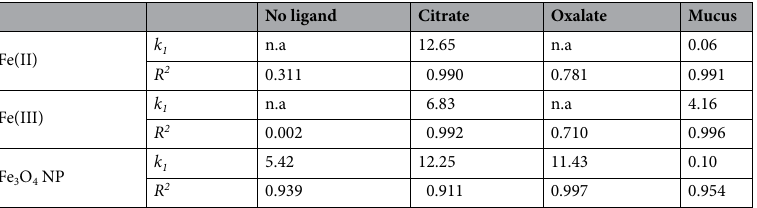
Table 1. Apparent kinetic rate constants of the first-order, (10 2 k 1 ; min −1 ) and corresponding correlation coefficients ( R 2 ) calculated from the reaction kinetics of bromophenol blue degradation at neutral pH (when R 2 < 0.9 the corresponding k 1 is not